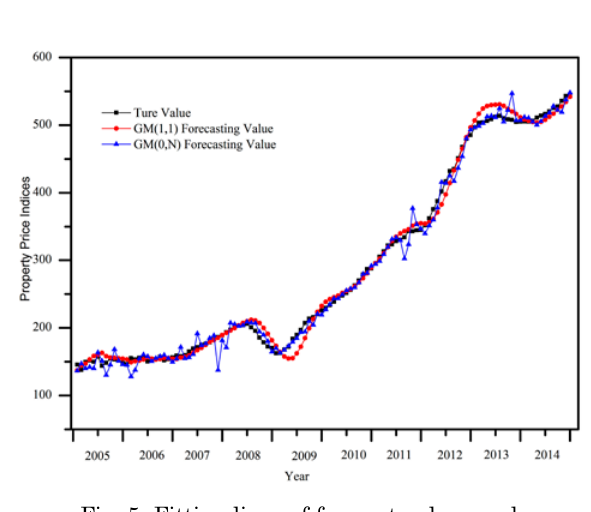
Fig. 5. Fitting lines of forecast values and